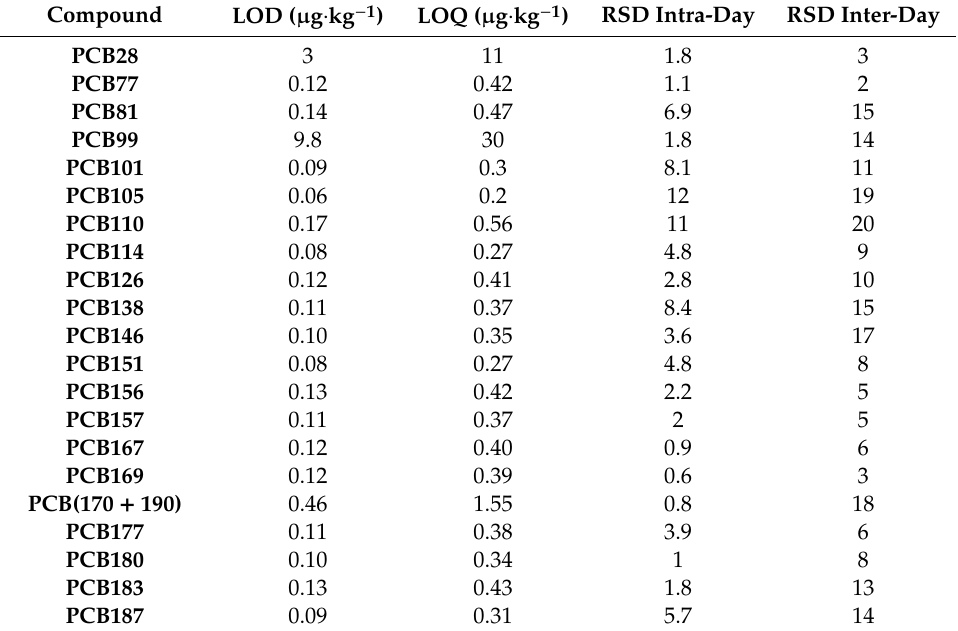
Table 1. LOD, LOQ and intra- and inter-day reproducibility of method.